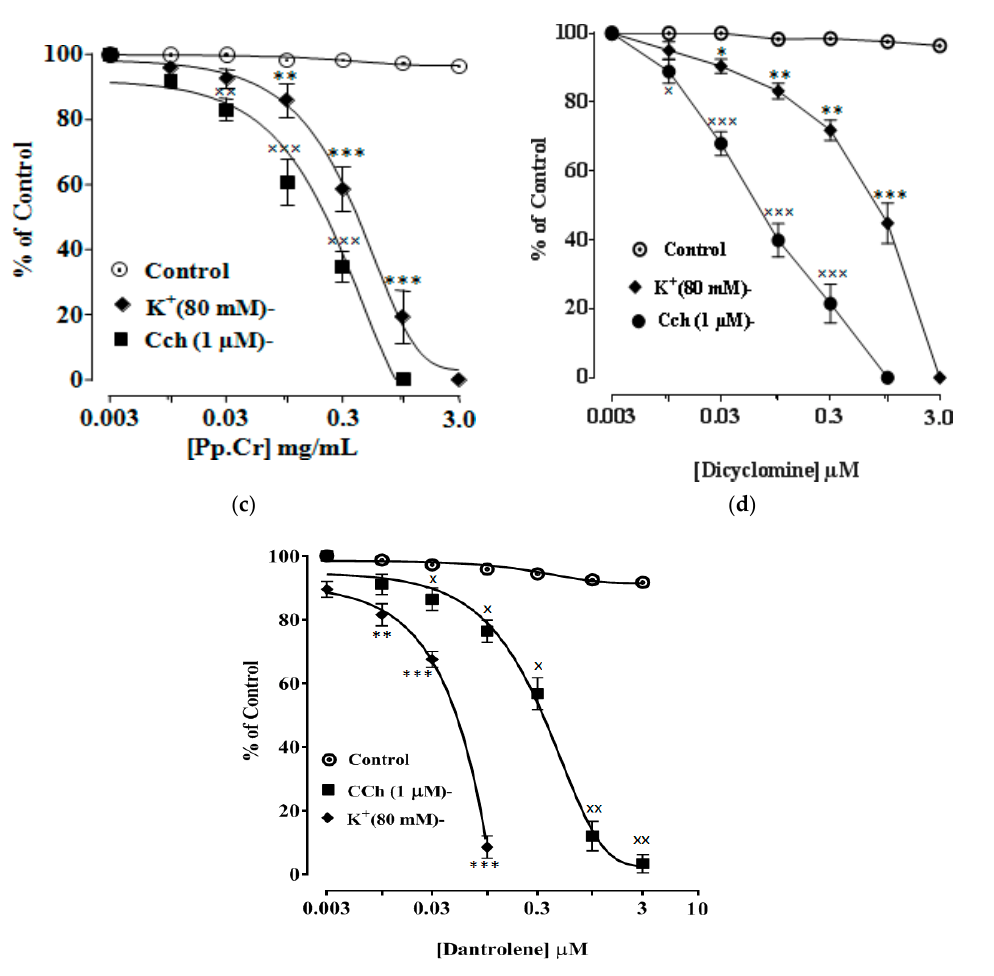
Figure 5. Concentration-dependent inhibitory effect of Pp.Cr (mg/mL) ( a – c ), dicyclomine (µM) ( d ) and dantrolene (µM) ( e ) against K + (80 mM)- and Cch (1 µM)-induced trachea contractions. * p < 0.05, ** p < 0.01, and *** p < 0.001 compares the effects of various conc. of Pp.Cr (mg/mL) on K + (80 mM)-induced trachea contractions. × p < 0.05, ×× p < 0.01, and ××× p < 0.001 compares the effects of various conc. of Pp.Cr (mg/mL) on Cch (1 µM)-induced trachea contractions. (Mean ± SEM, n = 5).